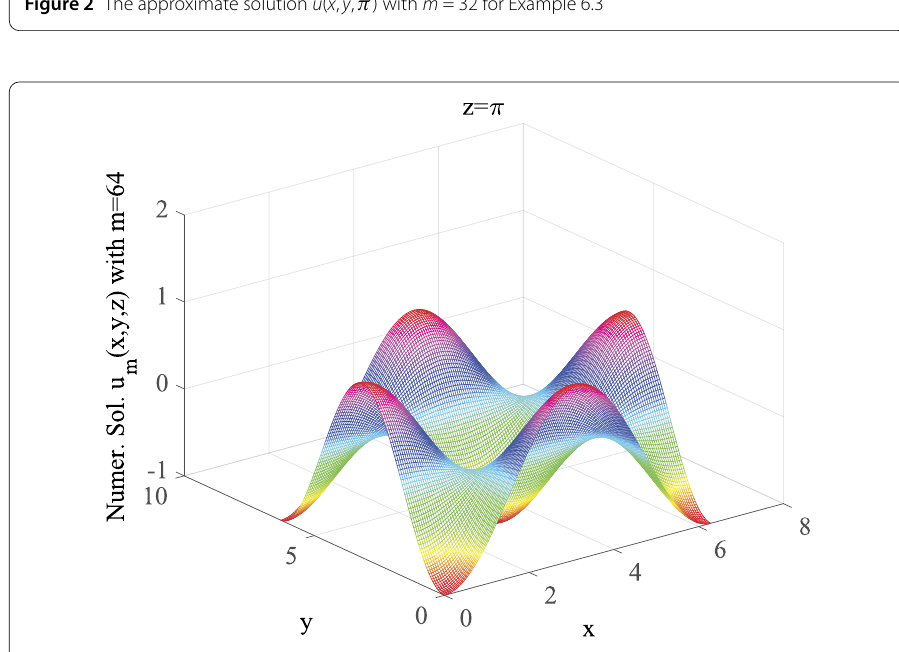
Figure 3 The approximate solution u ( x , y , π ) with m = 64 for Example